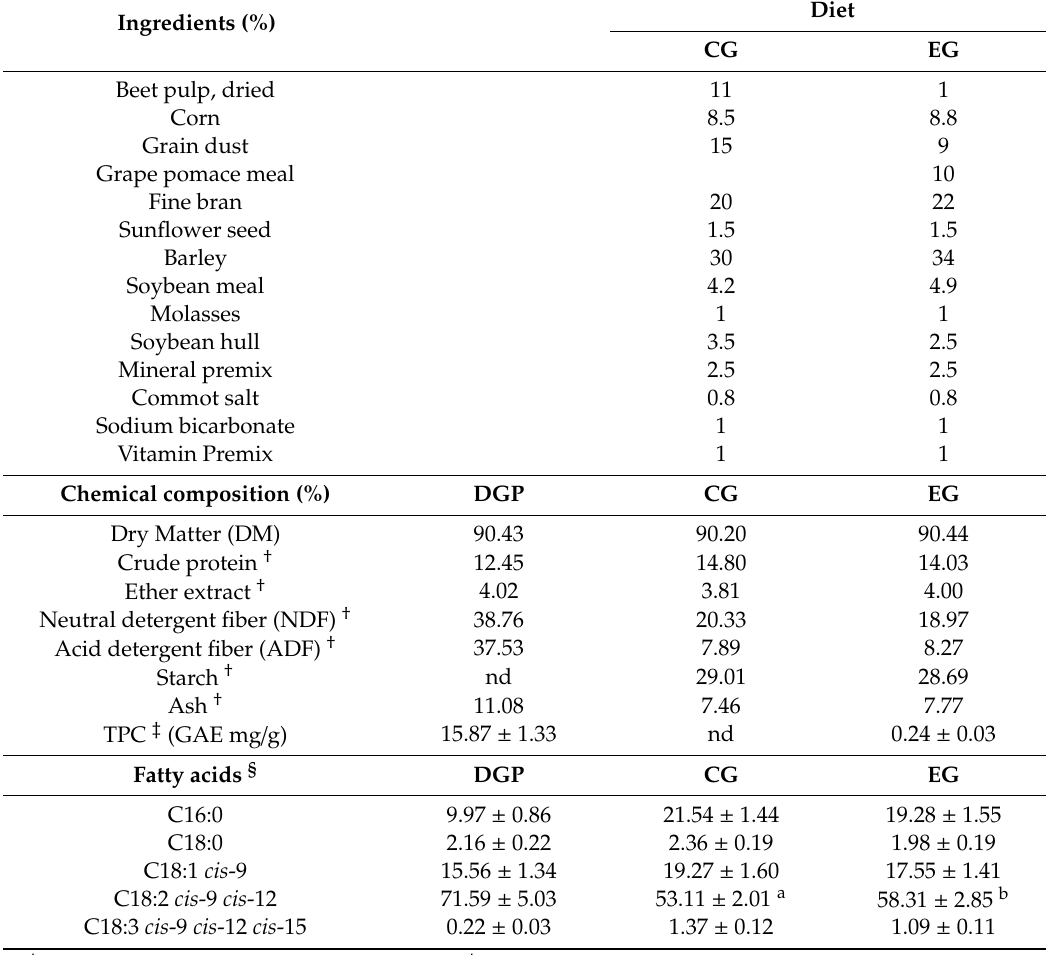
Table 2. Ingredients and chemical composition of the custom-formulated concentrate respectively administered to control group (CG) and experimental group